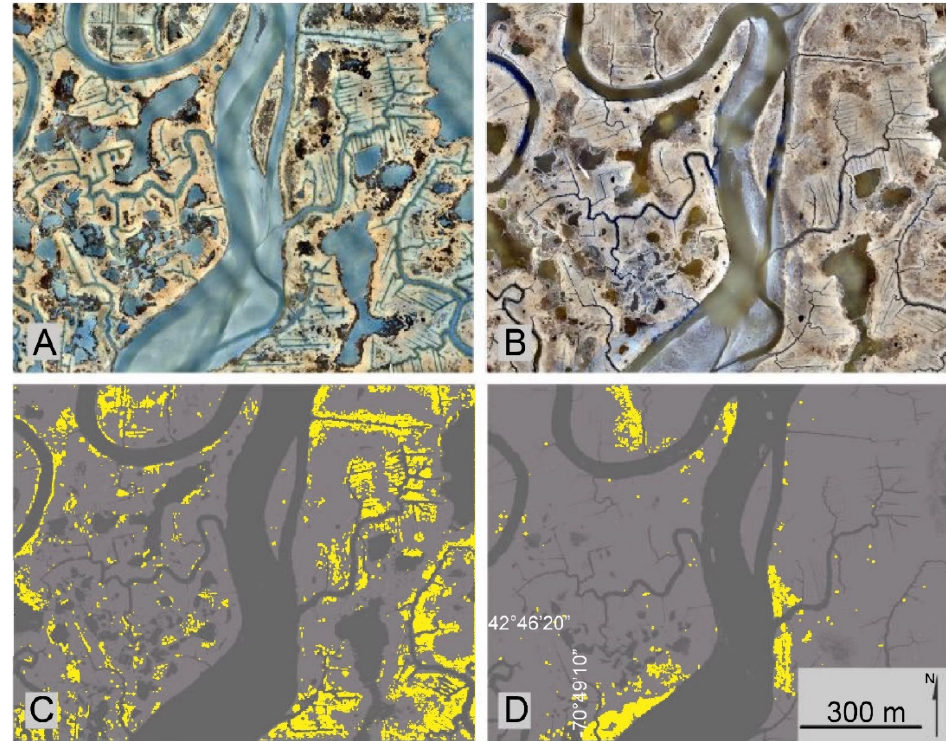
Figure 4. rue color orthoimages (4A, 4B) and corresponding classified land cover maps showing Figure 4. True color orthoimages ( A , B ) and corresponding classified land cover maps showing water water (dark gray), marsh (gray), and sediment (yellow). Tiles 4A and 4C show data from 14 No ‐ (dark gray), marsh (gray), and sediment (yellow). Tiles ( A , C ) show data from 14 November 2017; vember 2017; tiles 4B and 4D show data from 27 February 2018. tiles ( B , D ) show data from 27 February